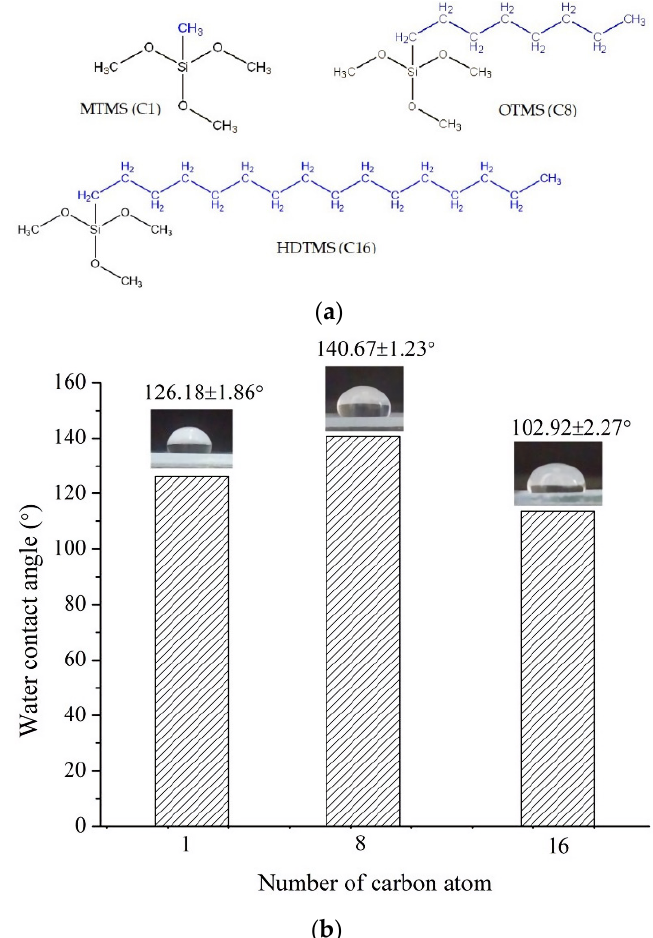
Figure 9. ( a ) The molecular structure of MTMS (C1), OTMS (C8), HDTMS (C16), and ( b ) water contact angles, measured on SiO 2 -TiO 2 -alkylsilane coated glass samples.